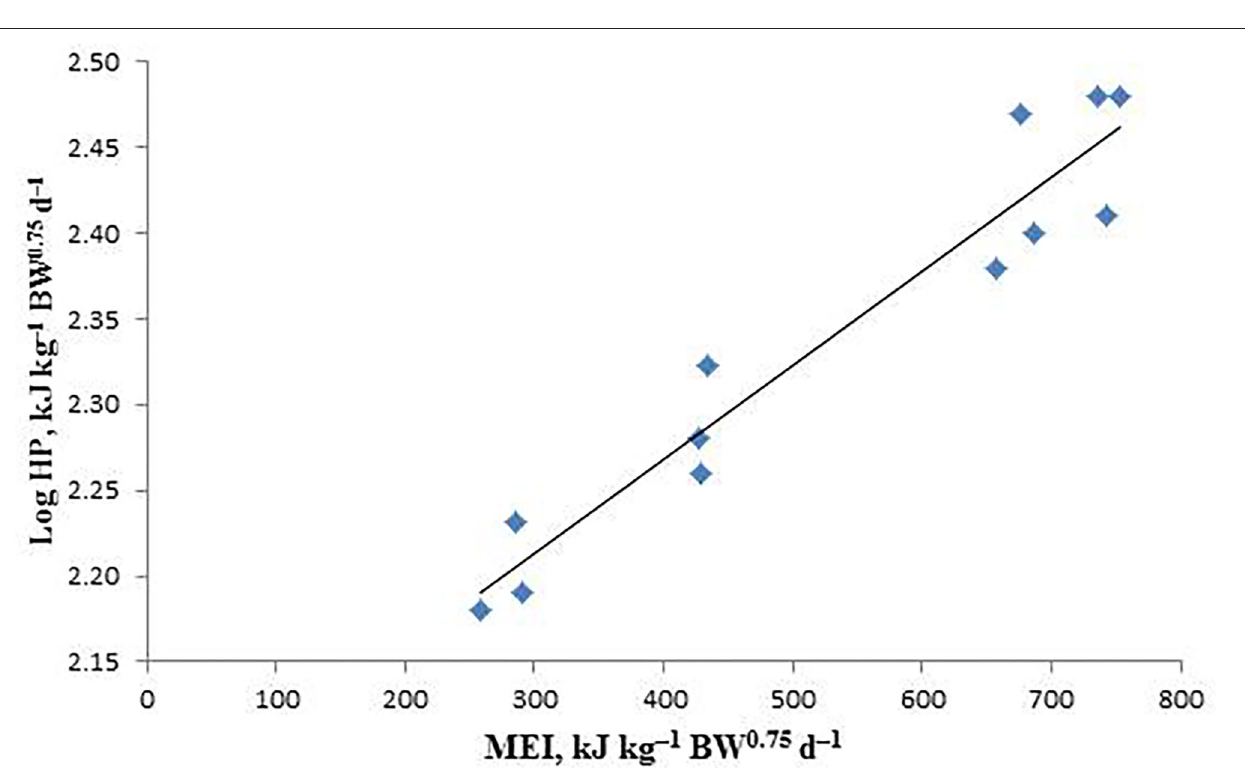
FIGURE 1 | The relationship between the logarithm of heat production (HP) and metabolizable energy intake (MEI) of sika deer in the indirect calorimetry method. LogHP = 2.3495( ± 0.0212) + 0.0005( ± 0.0002) × MEI; R 2 = 0.9246, P < 0.001, n =